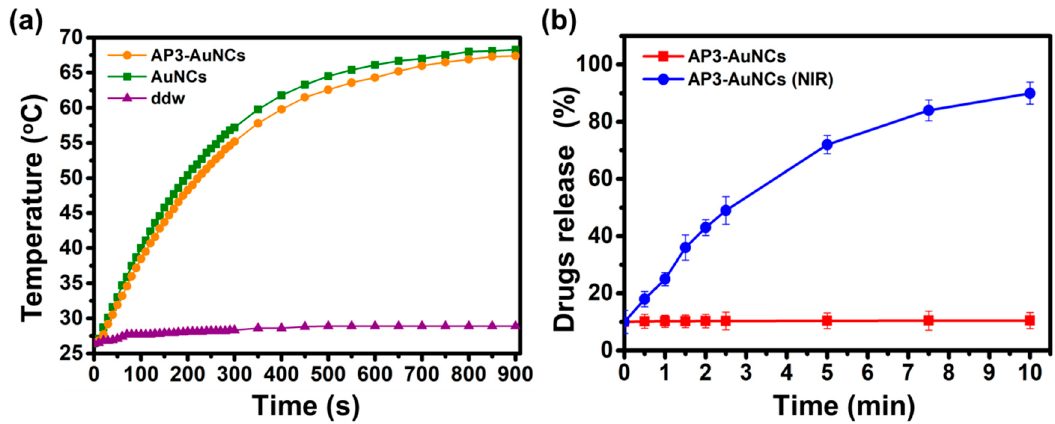
Figure 4. ( a ) Profile of temperature increase for 50 µ g/mL AuNCs and AP3-AuNCs upon 808 nm laser irradiation at a power density of 1 W/cm 2 . ( b ) Cumulative AP3 release from AP3-AuNCs with NIR irradiation time.